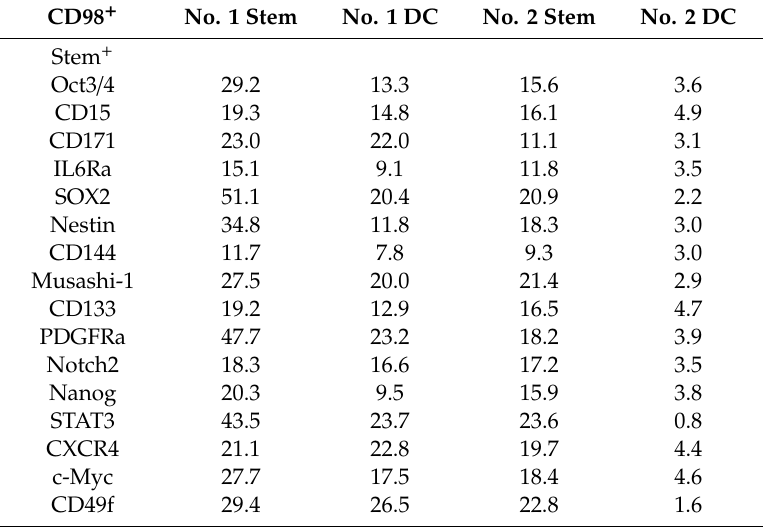
Table2. PercentagesofCD98 + / stemmarker + cellsamonggliomastem-likecells(Stem)anddi ff erentiated cells (DC) from no. 1 and no.